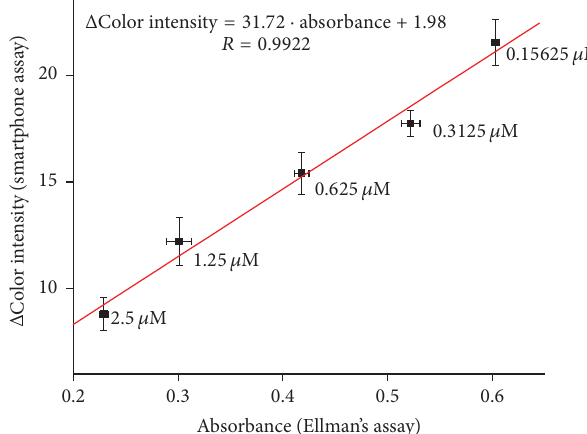
Figure 7: Validation of galanthamine assay compared to standard Ellman’s assay. Error bars for smartphone assay represent standard error of the mean and for Ellman’s assay standard deviation for 𝑛 =